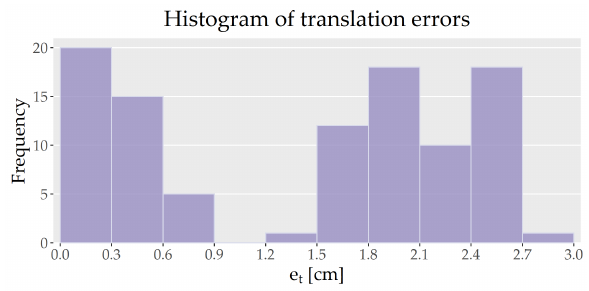
Figure 6. The empirical distribution of translation errors. metre box centred on a location, applying a random transforma- tion to this cropped part, and attempting an automated registra- tion back to the reference model. The random transformation gives us the true transformation, i.e. the ground truth, which makes it possible to assess the registration accuracy from the differences between the ground truth and estimated registra- tions.